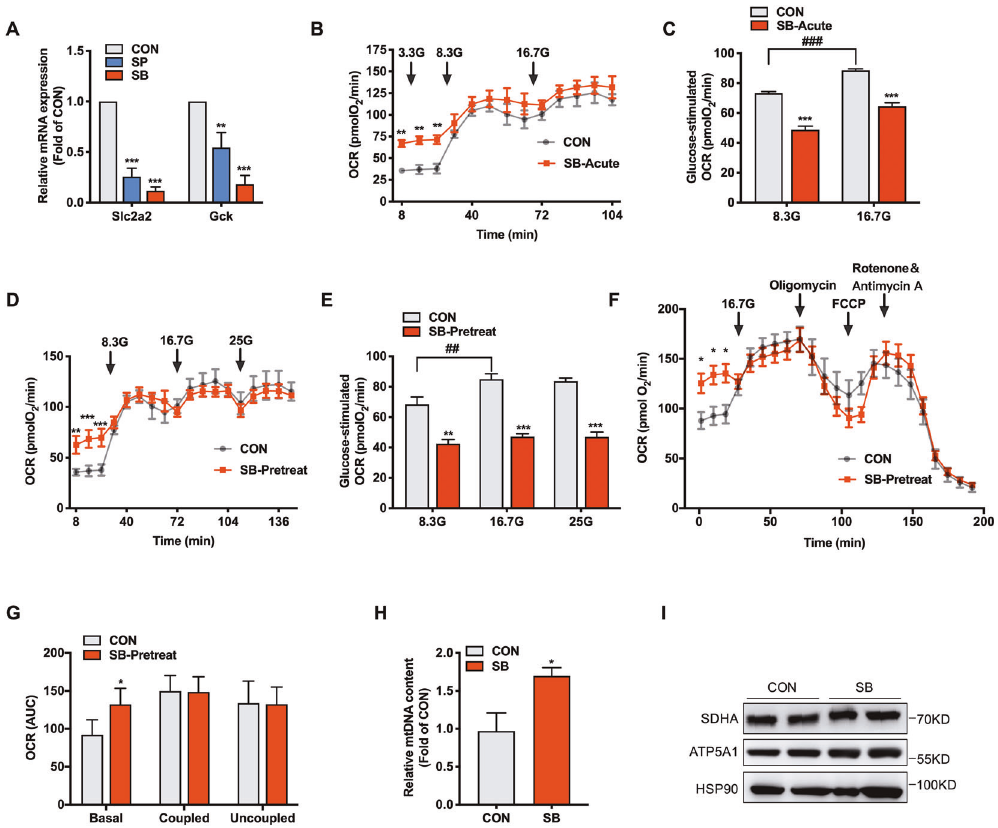
consumption rate (OCR) in rat islets treated with 5 mM SB for 1 h. C Determination of glucose-stimulated OCR based on B . D Basal and glucose-stimulated OCR in rat islets treated with 5 mM SB for 24 h. E Determination of glucose-stimulated OCR based on D. F After rat islets were treated with 5 mM SB for 24 h, OCR was measured in the presence of 25 mM glucose, 1 μ M oligomycin, 2 μ M FCCP, or 0.5 μ M rotenone/ antimycin A at the indicated time points (arrows). G Determination of basal, coupled, and uncoupled respiration in F . H mtDNA content in INS- 1 cells treated with 5 mM SB for 24 h. I SDHA (Complex II) and ATP5A1 (Complex V) protein expressions in INS-1 cells treated with 5 mM SB for 24 h. Data were given as mean ± SD for three separate experiments. * p < 0.05, ** p < 0.01, *** p < 0.001 vs control (CON) group. ## p < 0.01, ### p <